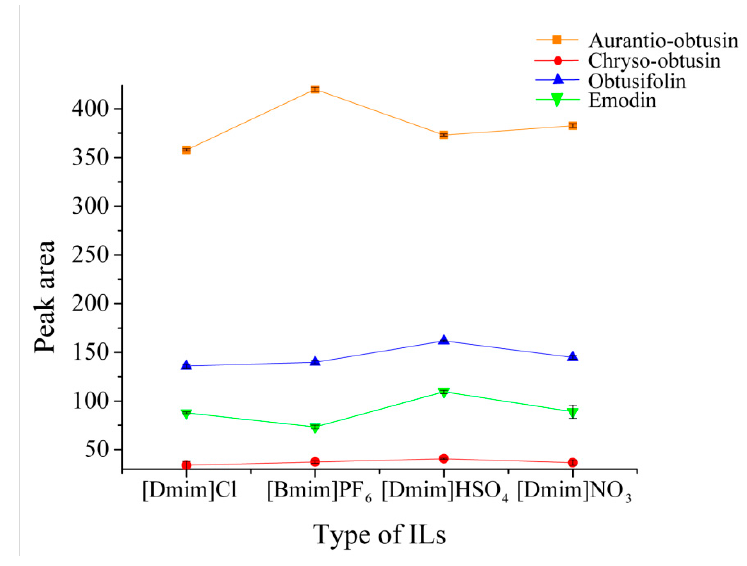
Figure 4. Effect of different ILs in VS-MSPD process. Figure 4 . Effect of different ILs in VS-MSPD process.